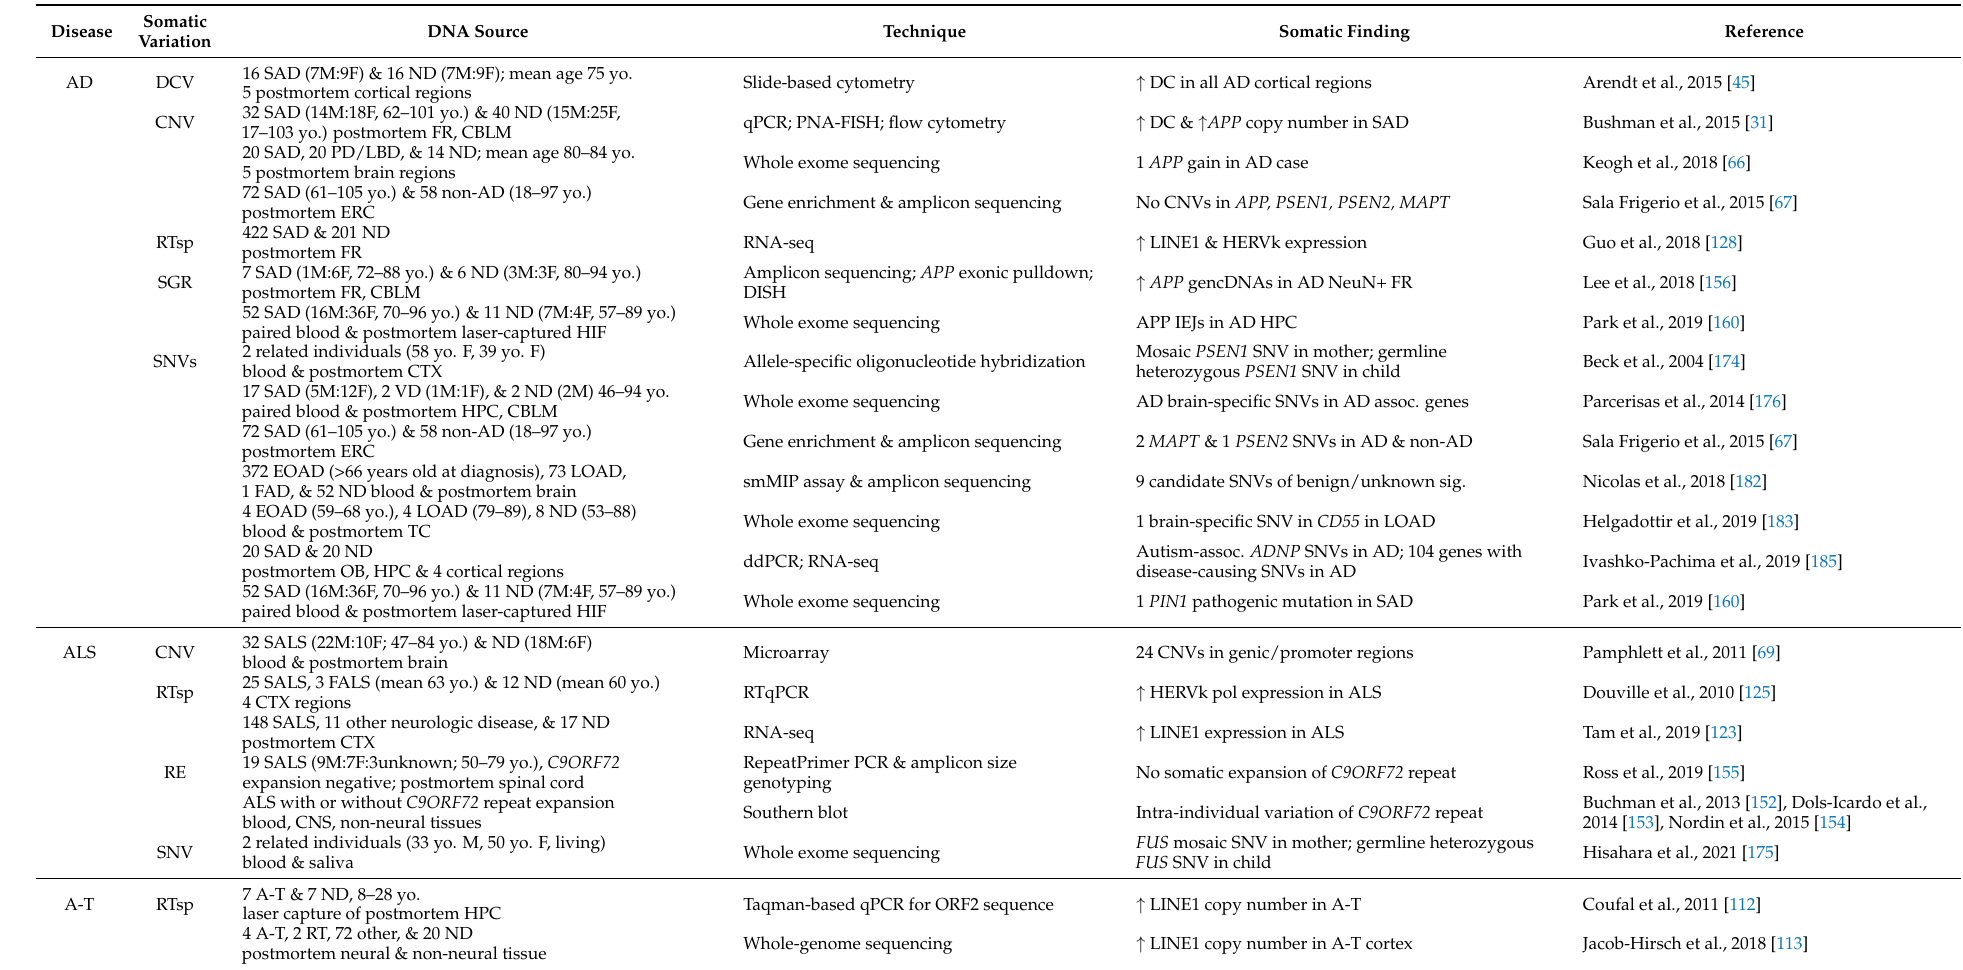
Table A1. Summary of studies examining somatic mutations in neurodegenerative